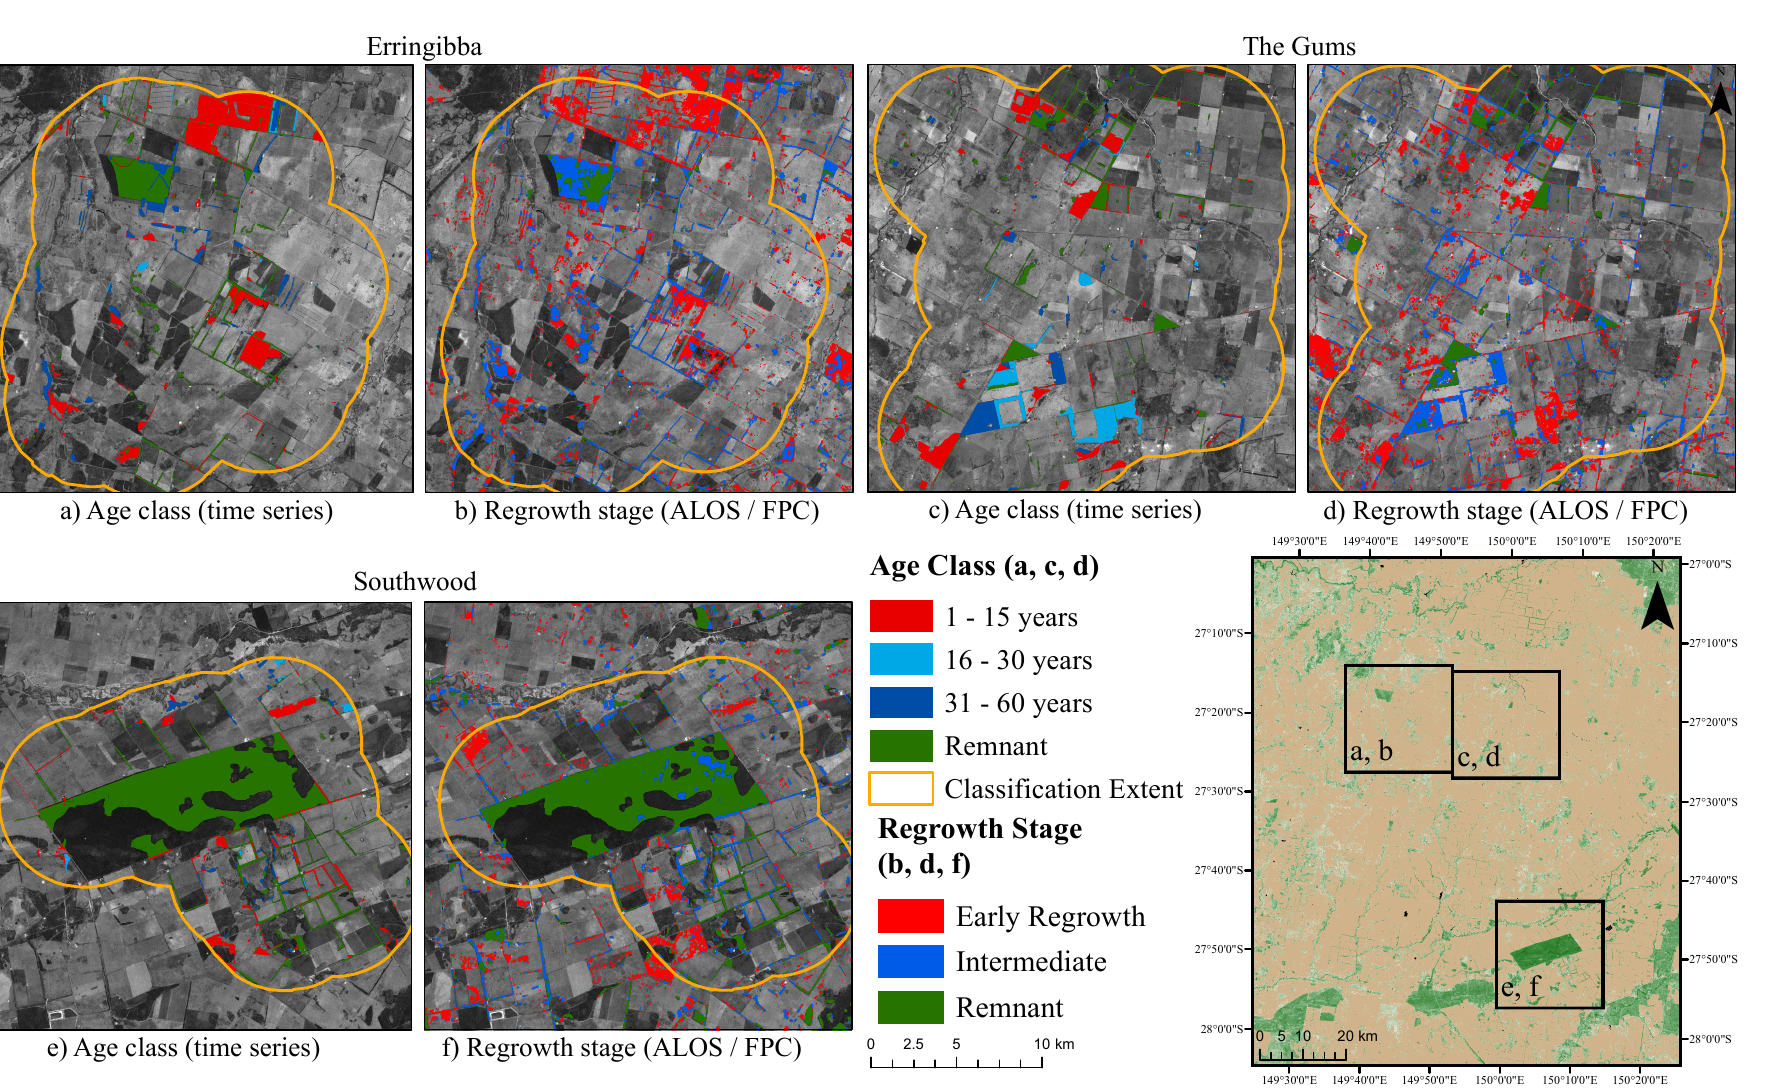
Figure 4. Maps of regrowth stage for three key areas in the Tara Downs sub-region; Erringibba ( a , b ), The Gums ( c , d ) and Southwood ( e , f ). Regrowth stages were assigned through ( a , c , e ) time-series comparison of aerial photography and high resolution satellite data [6] and ( b , d , f ) using a combination of ALOS PALSAR and Landsat-derived FPC data for Eringibba, the Gums and Southwood. In both classifications only woody vegetation, defined as having an FPC > 9%, was